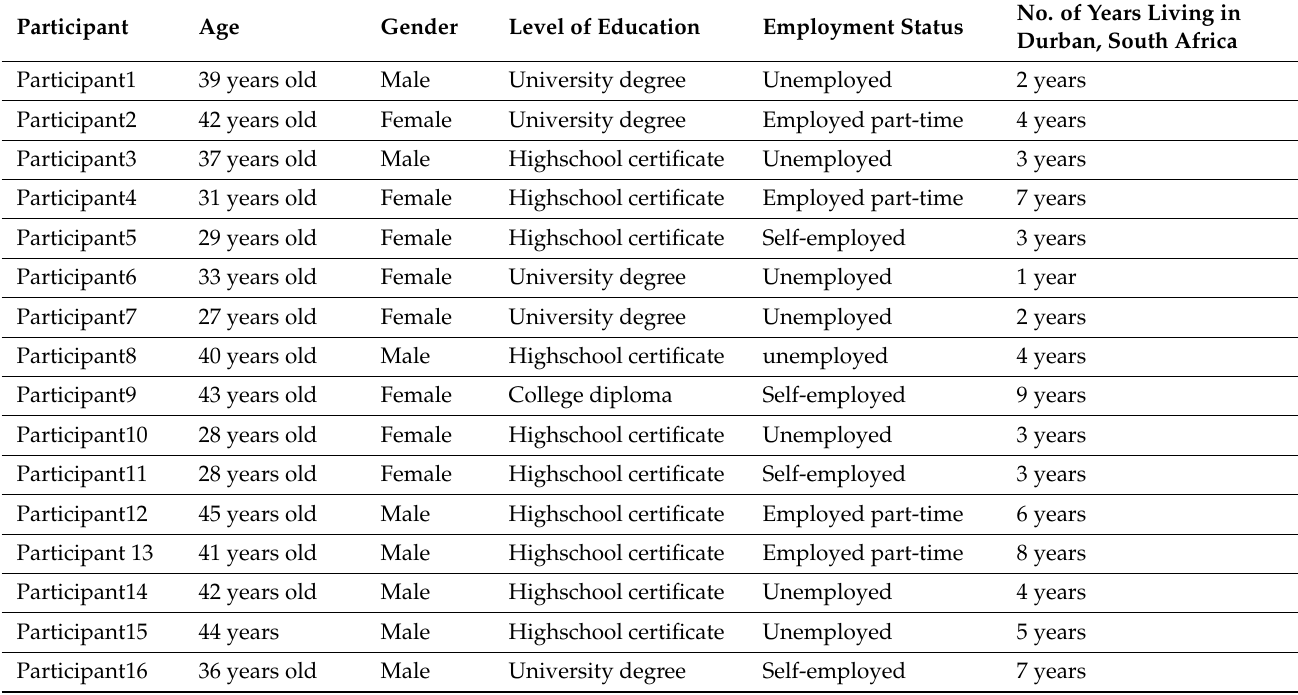
Table 1. Demographic profile of